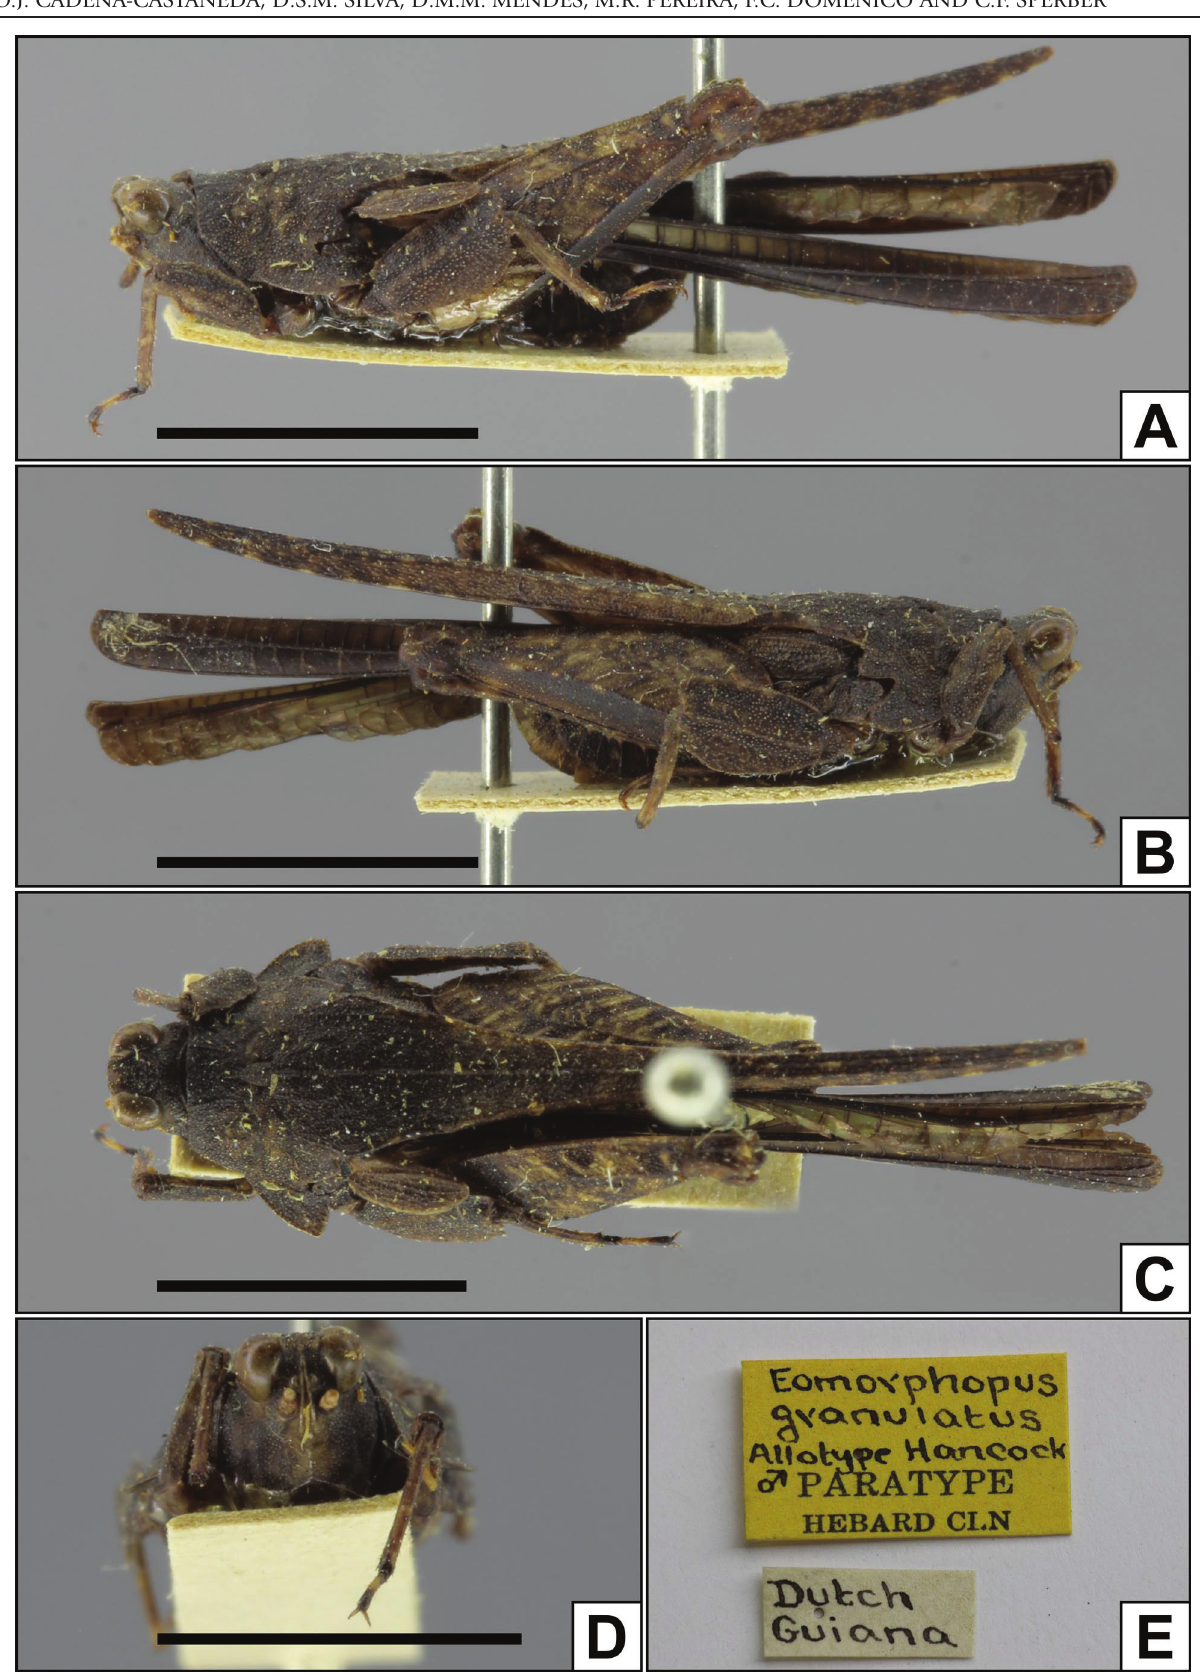
Fig. 5. Eomorphopus granulatus (male paralectotype) A. Lateral left habitus; B. Lateral right habitus; C. Dorsal view; D. Head details in frontal view; and E. Labels. Scale bars: 5